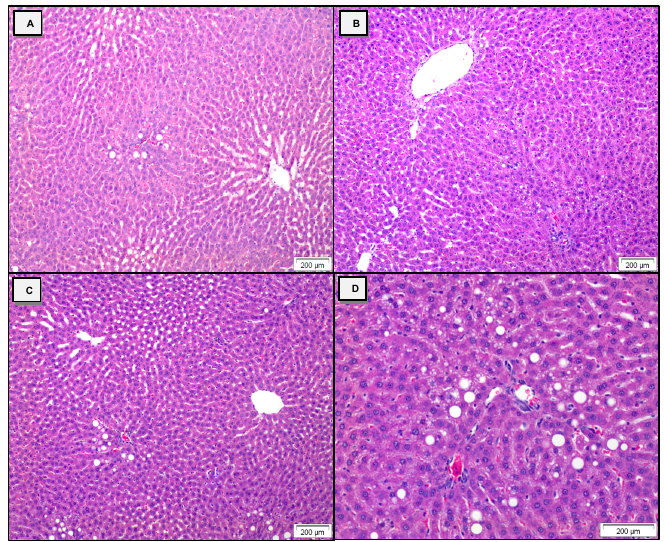
FIGURE 3 - Microphotograps of liver tissue showing histological aspects of animals refed with high-fructose diet for 45 days (A), 60 days (B) and 90 days (C and D). H&E, 10x (A, B and C) and 20x